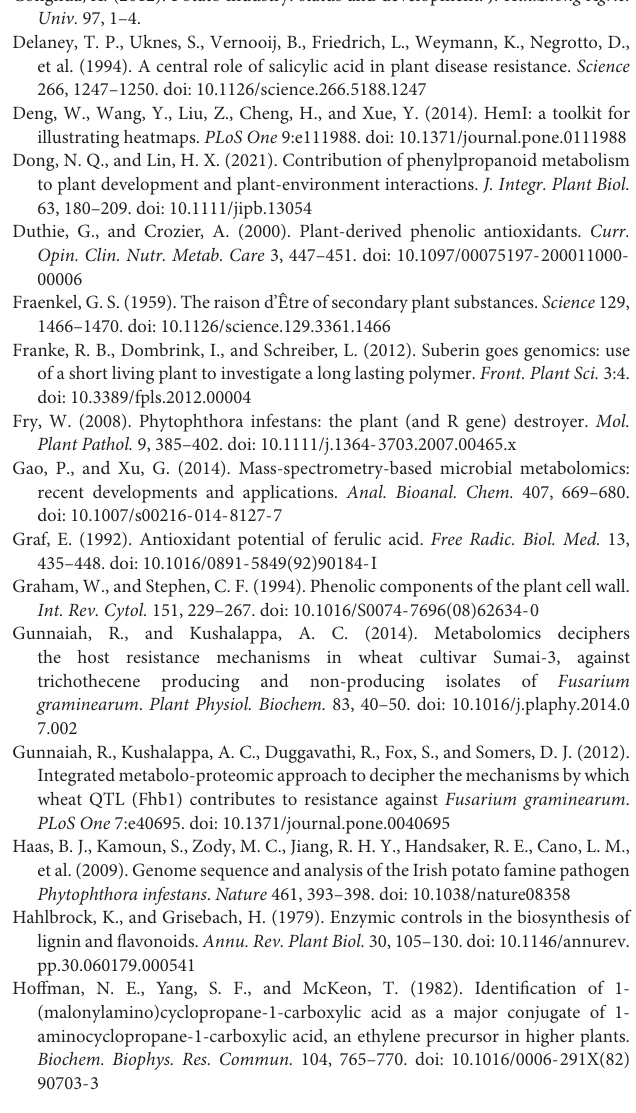
Supplementary Figure 1 | Correlation analyses of different samples collected from compatible and incompatible interactions. Correlation analyses were performed based on the metabolites identified under the positive ion model. (A) Sample correlation PLS-DA diagram. (B) Sample correlation heatmap. Supplementary Figure 2 | Metabolites expression patterns between the compatible and incompatible interaction at 0 hbi. Metabolites with altered abundances (irrespective of the p -value and VIP value) at 0 hbi were divided into ten subclusters according to the expression patterns (A) . A number of metabolites for each subcluster were counted (B) . Each column represents a sample, each row represents a metabolite, and the color indicates the relative abundance of metabolites. Supplementary Figure 3 | Metabolites expression patterns between the compatible and incompatible interaction at 48 hpi. Metabolites with altered abundances (irrespective of the p -value and VIP value) at 48 hpi were divided into ten subclusters according to the expression patterns (A) . A number of metabolites for each subcluster were counted (B) . Each column represents a sample, each row represents a metabolite, and the color indicates the relative abundance of